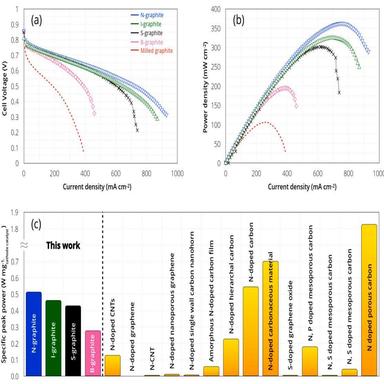
Performance of AEMFCs made with heteroatom-doped graphite cathode catalysts as compared to the undoped milled-graphite: polarization curves (a) and power density curves as a function of current density (b). Cathode catalyst loading of 0.70 mgdoped-graphitecm–2 (96 % RH with 2.0 bar back pressure) and anode catalyst loading of 0.70 mgPtRucm–2 (79 % RH with no backpressure). Cell temperature 60 ◦C, H2 and O2 flow rates are 1000 mL min–1 . Comparison of the AEMFC performance of the metal-free cathode: N-doped